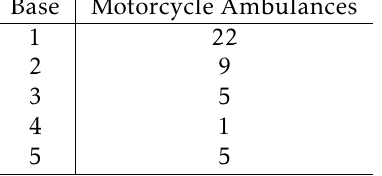
Figure 1. Main intersections with accidents Source: Own preparation